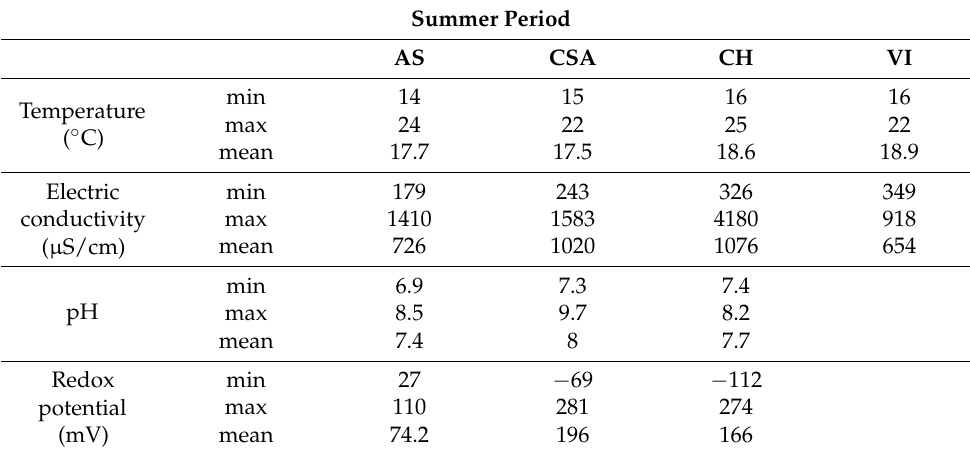
Table 4. Summery physico-chemical